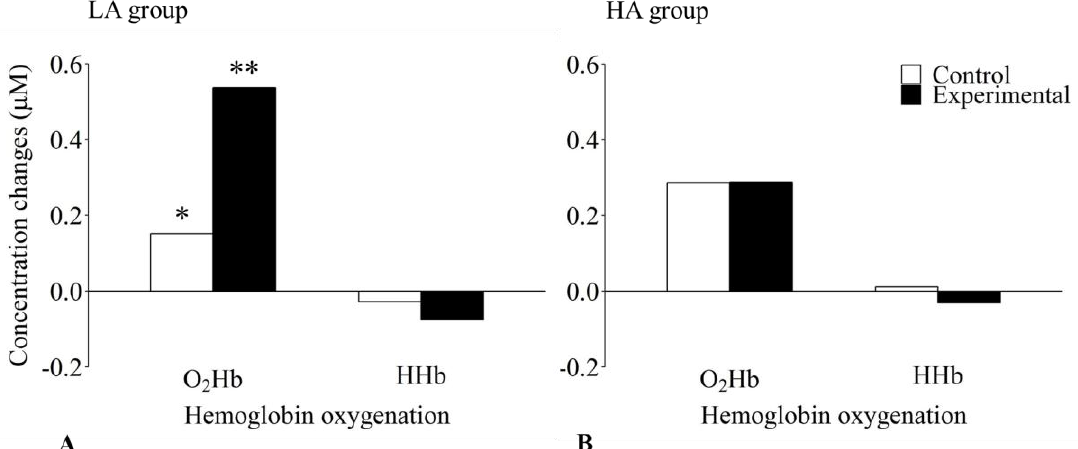
Figure 4. Effects of level of mental ability and condition on hemoglobin oxygenation concentration changes for the working memory task in the lower (LA; Panel A ) and the higher (HA; Panel B ) mental ability group. The lower mental ability group showed significantly increased oxygenated hemoglobin (O 2 Hb) and significantly decreased deoxygenated hemoglobin (HHb) concentrations in the experimental compared to the active control condition. No significant differences could be observed for the higher mental ability group. *: significantly different from O 2 Hb concentration change in the experimental condition ( p < 0.05). **: significantly different from HHb concentration change in the experimental condition ( p < 0.01).